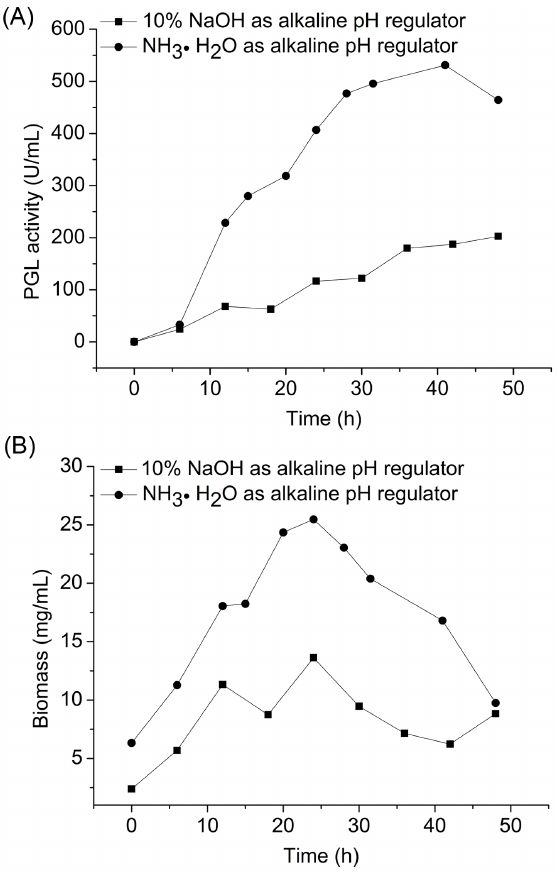
Figure 5. Comparison of PGL activity (A) and biomass (B) using ammonia or 10% NaOH as pH regulator in a 7.5 L